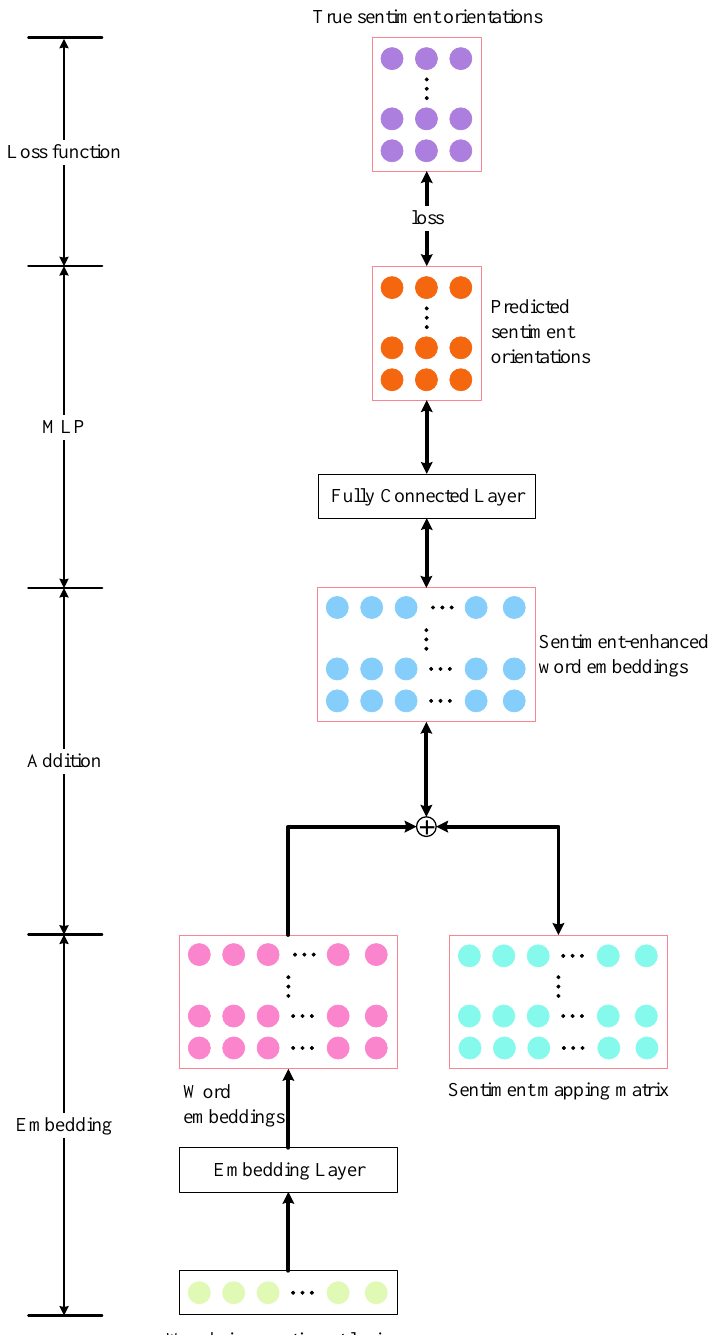
Figure 3. The training process diagram of the S-EWEs. The one-way arrow indicates forward propagation, and the two-way arrows represent forward and backward